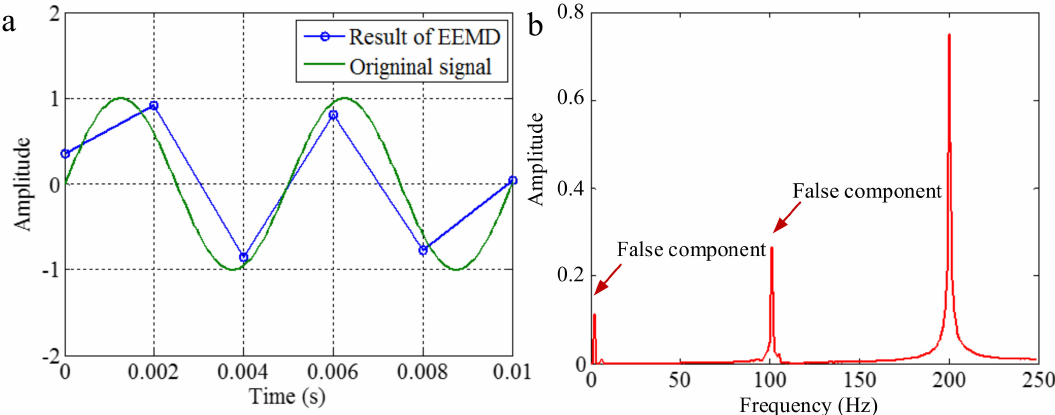
Figure 15. The EEMD result of the signal of 200 Hz with a sampling frequency of 2 kHz and the corresponding Fourier spectrum: ( a ) the result of EEMD and ( b ) the Fourier